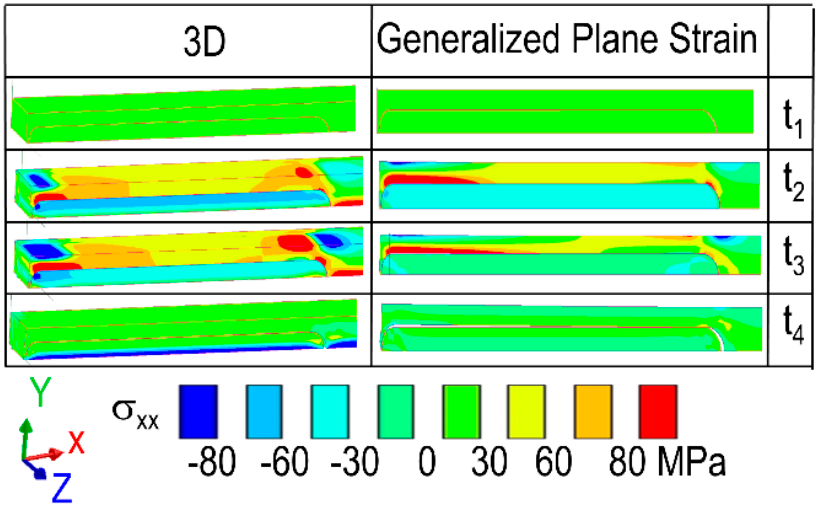
Figure 9. Axial stress, σ xx , predicted by the three-dimensional (3D) and the two-dimensional (2D) generalized plane strain models with an initial gap of 5 µm.